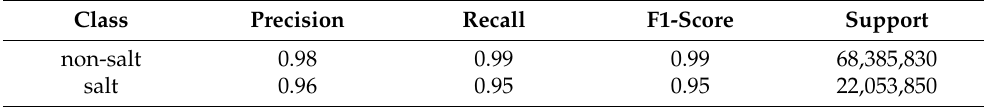
Table 4. The classification report for the training process on synthetic seismic data.